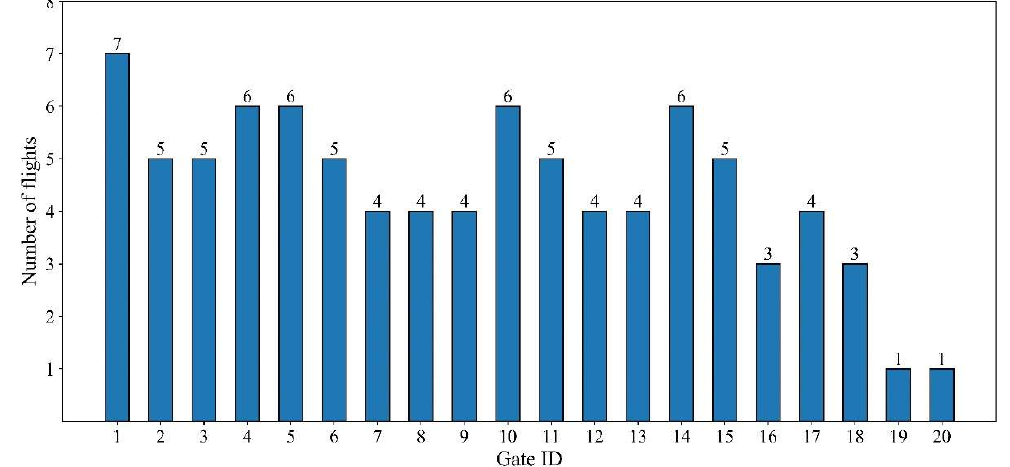
Figure 6. Number of flights allocated for each gate.